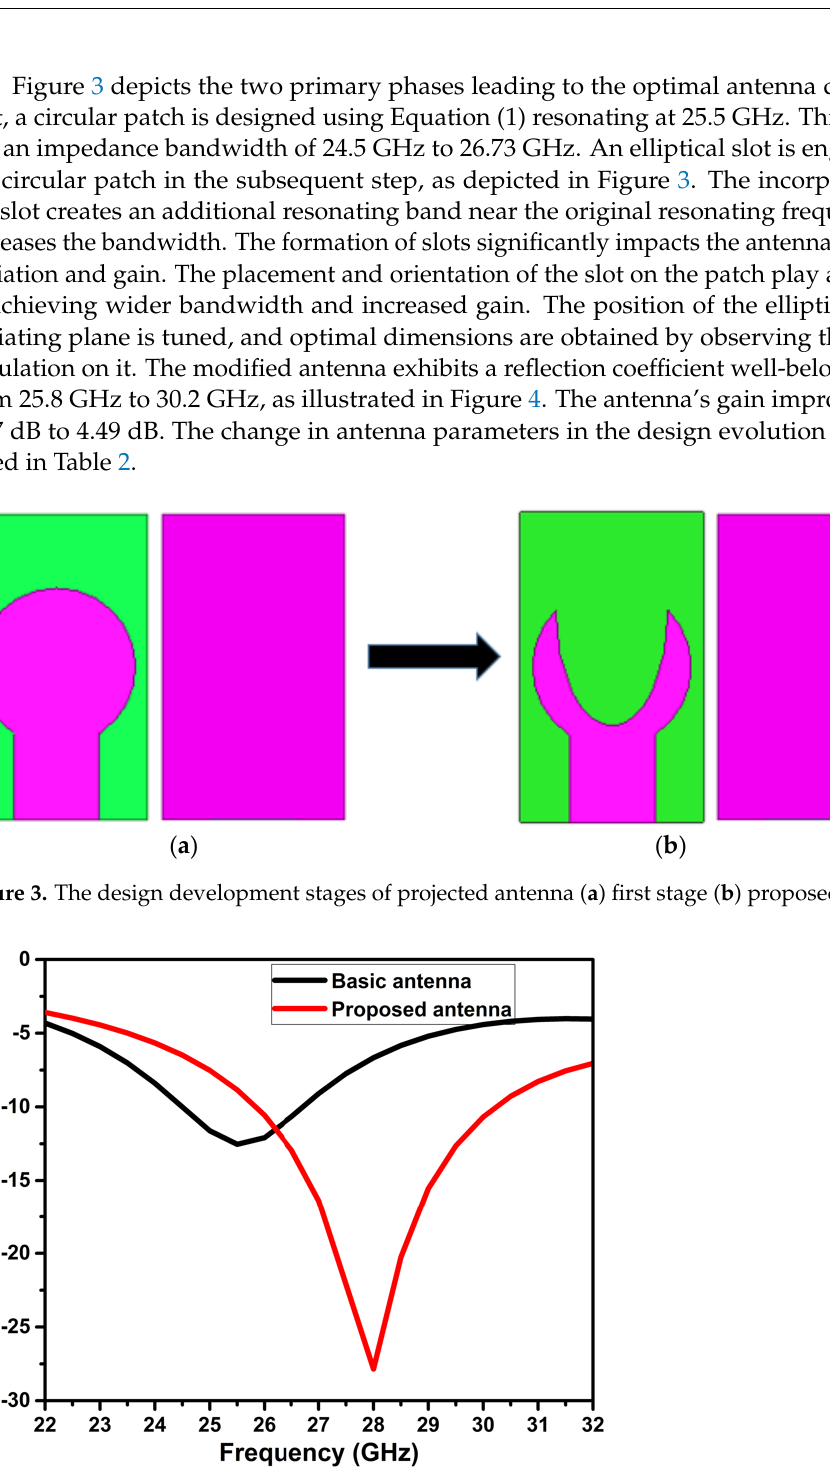
Figure 4. Reflection coefficient of the basic and proposed antenna. Table 2. Antenna parameters in the design evolution